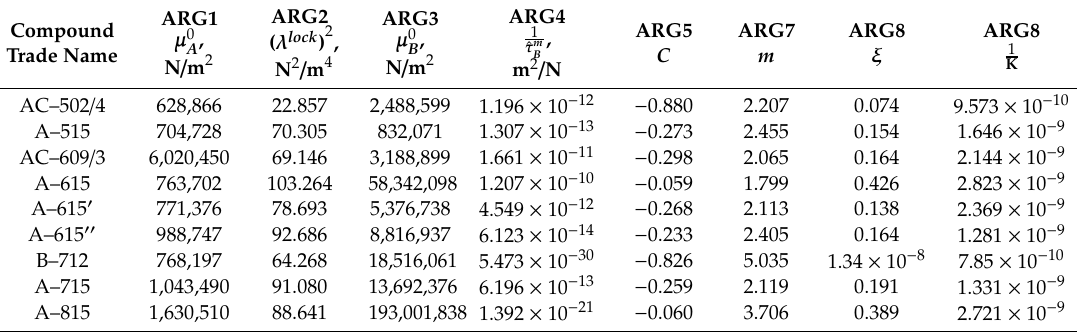
Table 6. Determined constants of Bergström–Boyce constitutive model.